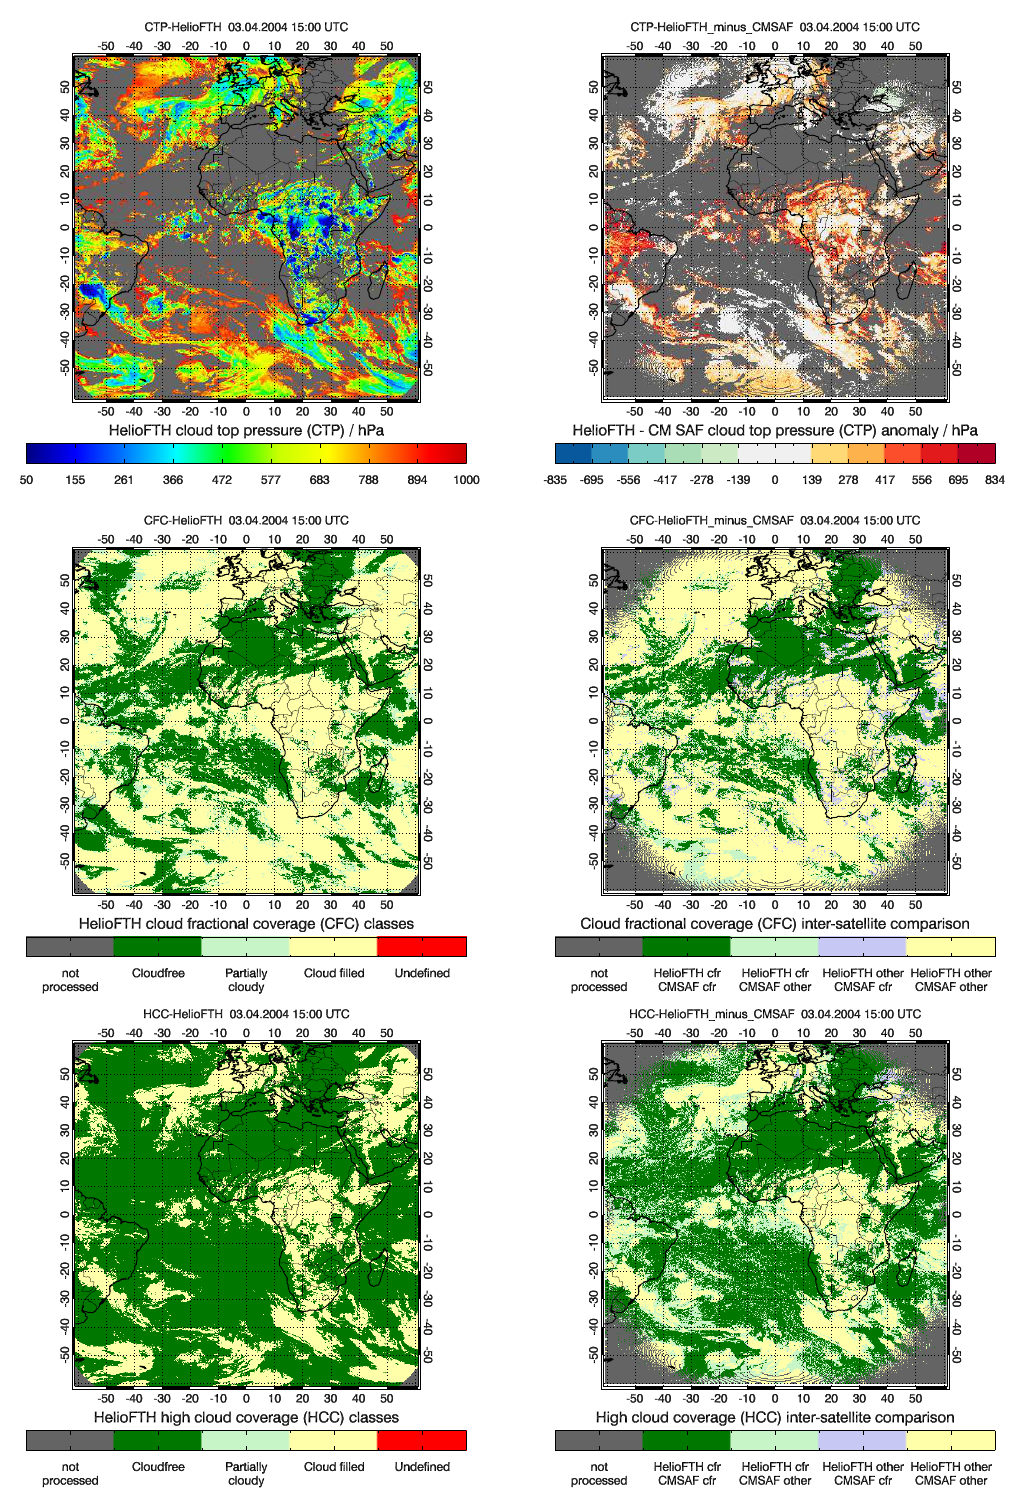
Fig. 4. 3 April 2004, 15:00UTC: cloud-top pressure (CTP), cloud fractional coverage (CFC) and middle and high cloud coverage (HCC) for HelioFTH (left hand side panels). Categorical differences of HelioFTH products to CM SAF CTP, CFC and HCC (right hand side panels) over full-disk.